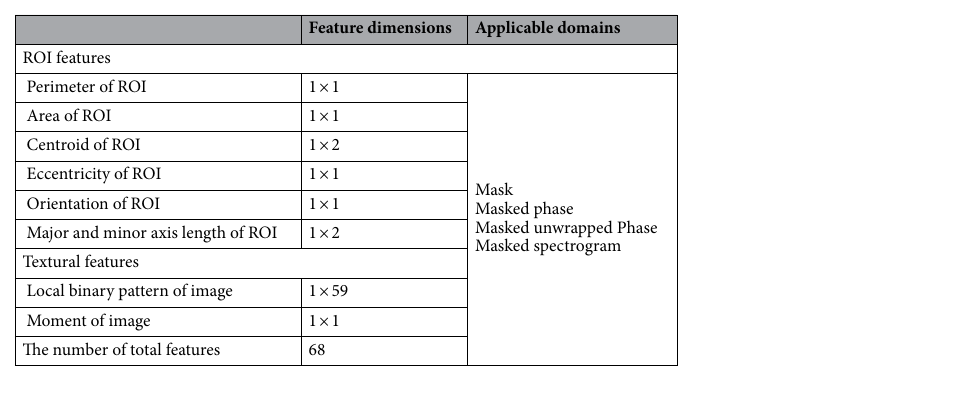
Table 2. 68 patent features and their data